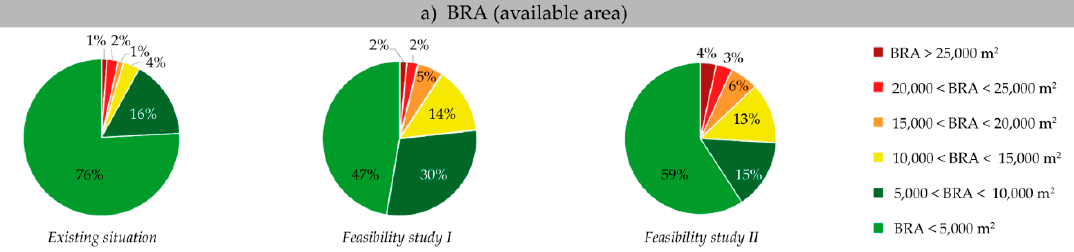
Figure 9. Urban analysis of Sluppen area: ( a ) BRA (m 2 ); ( b ) building height (m); ( c ) H/W analysis. Feasibility study I consists of 131 buildings with two dominating orientations: NE-SW and NW-SE. Despite very low and low (5000 < BRA < 10,000 m 2 ) BRA dominating the area, covering for 47% and 30% of the dwellings, respectively, the %BRA for feasibility study I is more than 2.5 times greater than the existing situation (Figure 9a). Here, 59% and the 35% of the buildings have very low and low (20 < H < 40 m) heights, respectively (Figure 9b); for half of the buildings (51%) the H / W ratio is very low (H / W < 2.0) (Figure 9c); and 77% of the buildings have flat roofs, while 23% of the structures have pitched roofs with inclination angles varying from 15 ◦ to 40 ◦ . Feasibility study II consists of 146 buildings and presents the same dominating orientations as in feasibility study I. The total %BRA is 3 times greater compared than in the existing situation, with 59% of total number of structures having low BRA (Figure 9a). The lowest buildings (59%) are situated in the peripheries of the neighborhood, while medium-height structures (39%) are located mainly between peripheries and the central part. Two high-rise buildings (H > 40 m) are situated in the core of the district (Figure 9b), which is dominated by very low (39%) and low (45%) H / W ratio (Figure 9c). Buildings with flat roofs cover 87% of the area, while the remaining 13% of the structures have pitched roofs with low roof inclinations of around 20 ◦ . 4.2. Step 2—Solar Irradiation Analysis Solar irradiation map analysis (Figure 10 shows an example related to feasibility study I) shows that in both existing and feasibility studies, the highest irradiation values are reached on the roofs in spring, while the lowest are reached in autumn (Table 12). In autumn and in winter, the highest values of solar irradiation are registered on the façades.